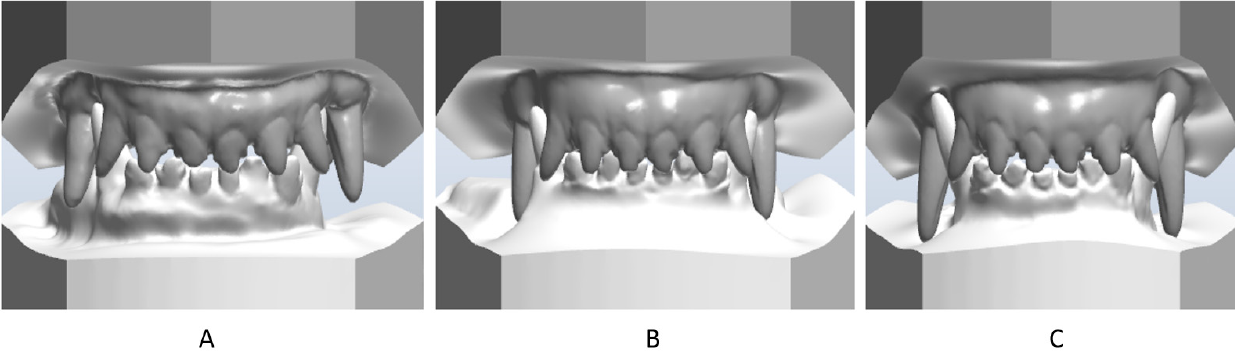
Figure 4. First case. Comparative en face occlusion scans—canine position and maxilla and mandible relationship. ( A ) before treatment, ( B ) after 2 months of treatment, ( C ) in the retention period (after 12 months of treatment).